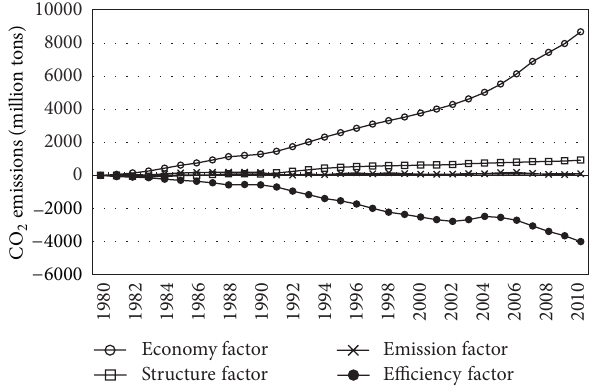
Figure 2: Decomposition results of industrial sector CO 2 emissions change (1981–2010).